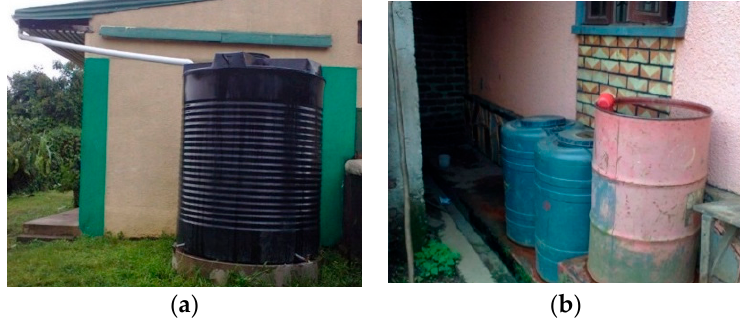
Figure 4. Illustrates the difference between formal and informal rainwater harvesting systems. ( a ) Formal harvesting systems; ( b ) Informal harvesting systems.